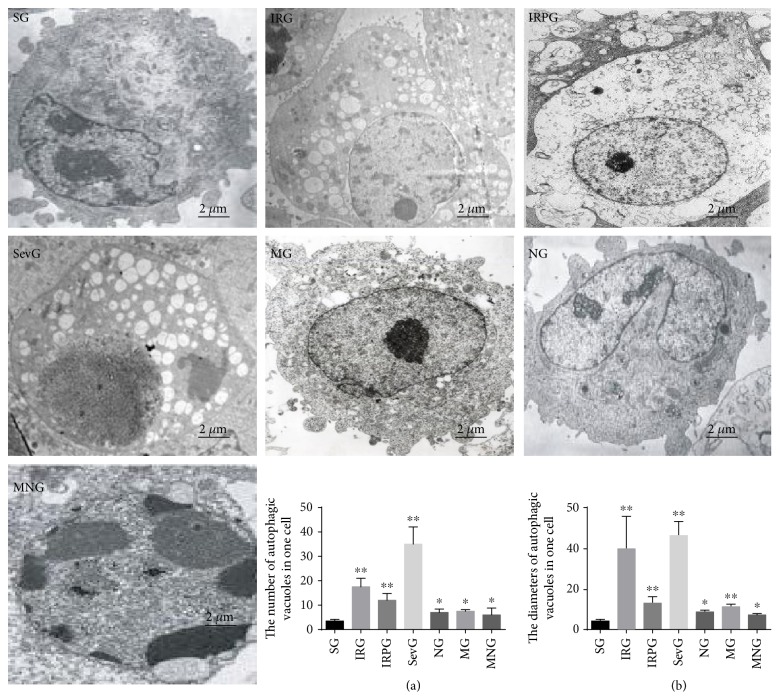
Myocardial cells were observed by transmission electron microscopy (×6000). (a) The number of autophagic vacuole in one cell. (b) The diameters of autophagic vacuole. All data were represented as mean values ± S.D. ∗P < 0.05 via SG and ∗∗P < 0.01 via SG, n = 7.